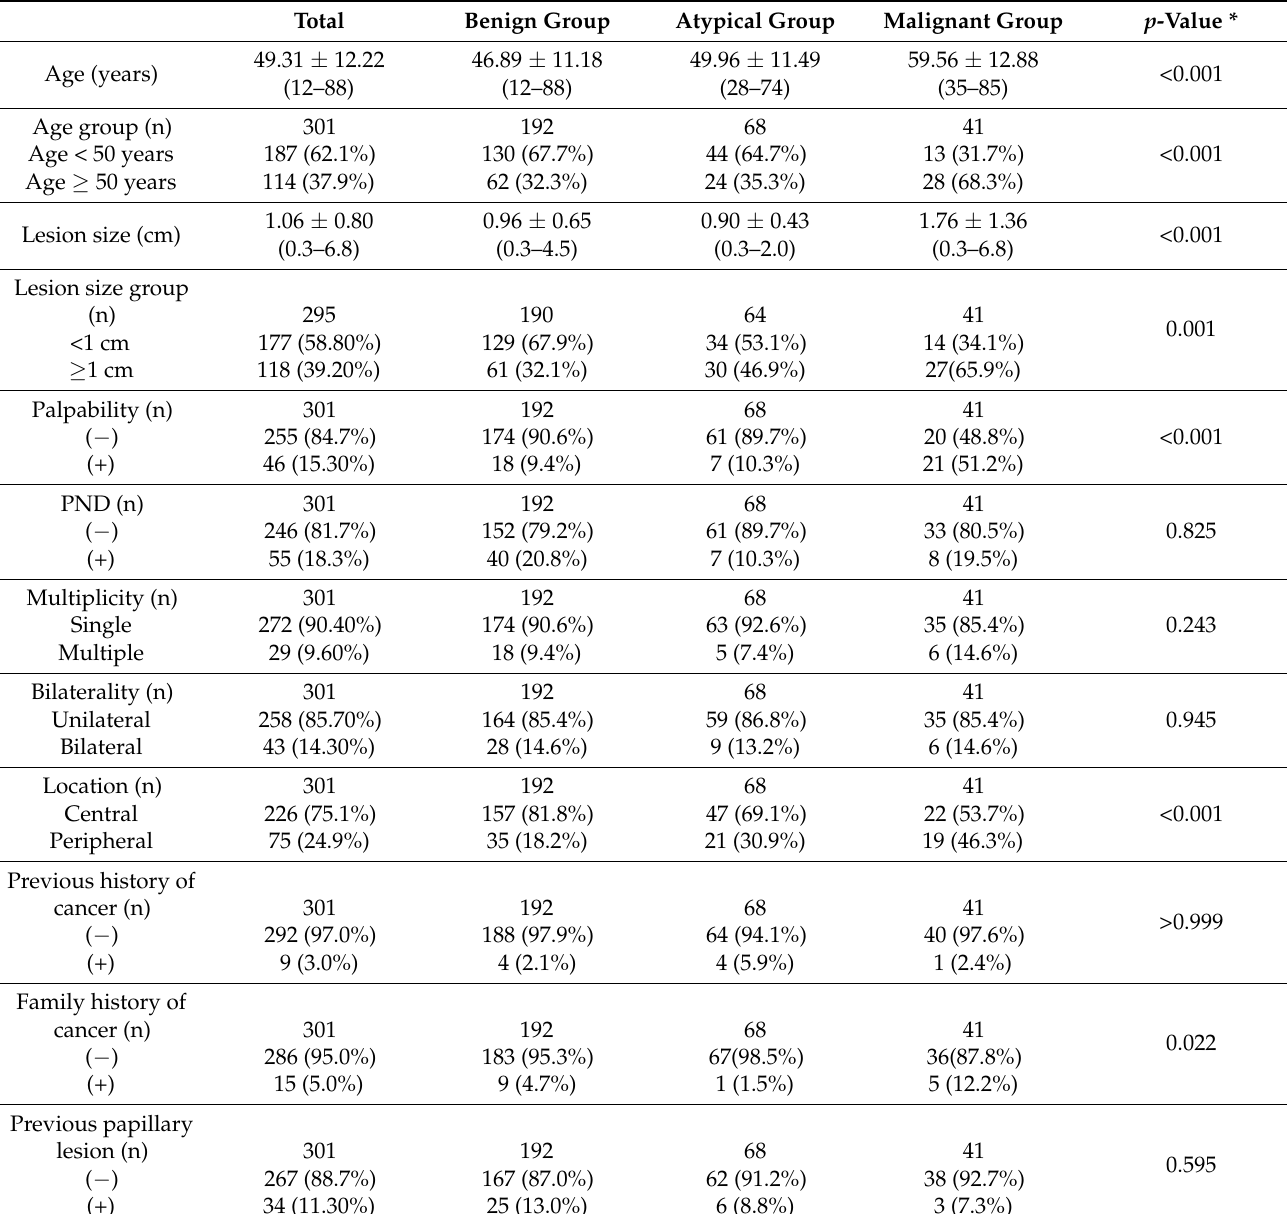
Table 1. Clinical characteristics of papillary lesions according to pathological